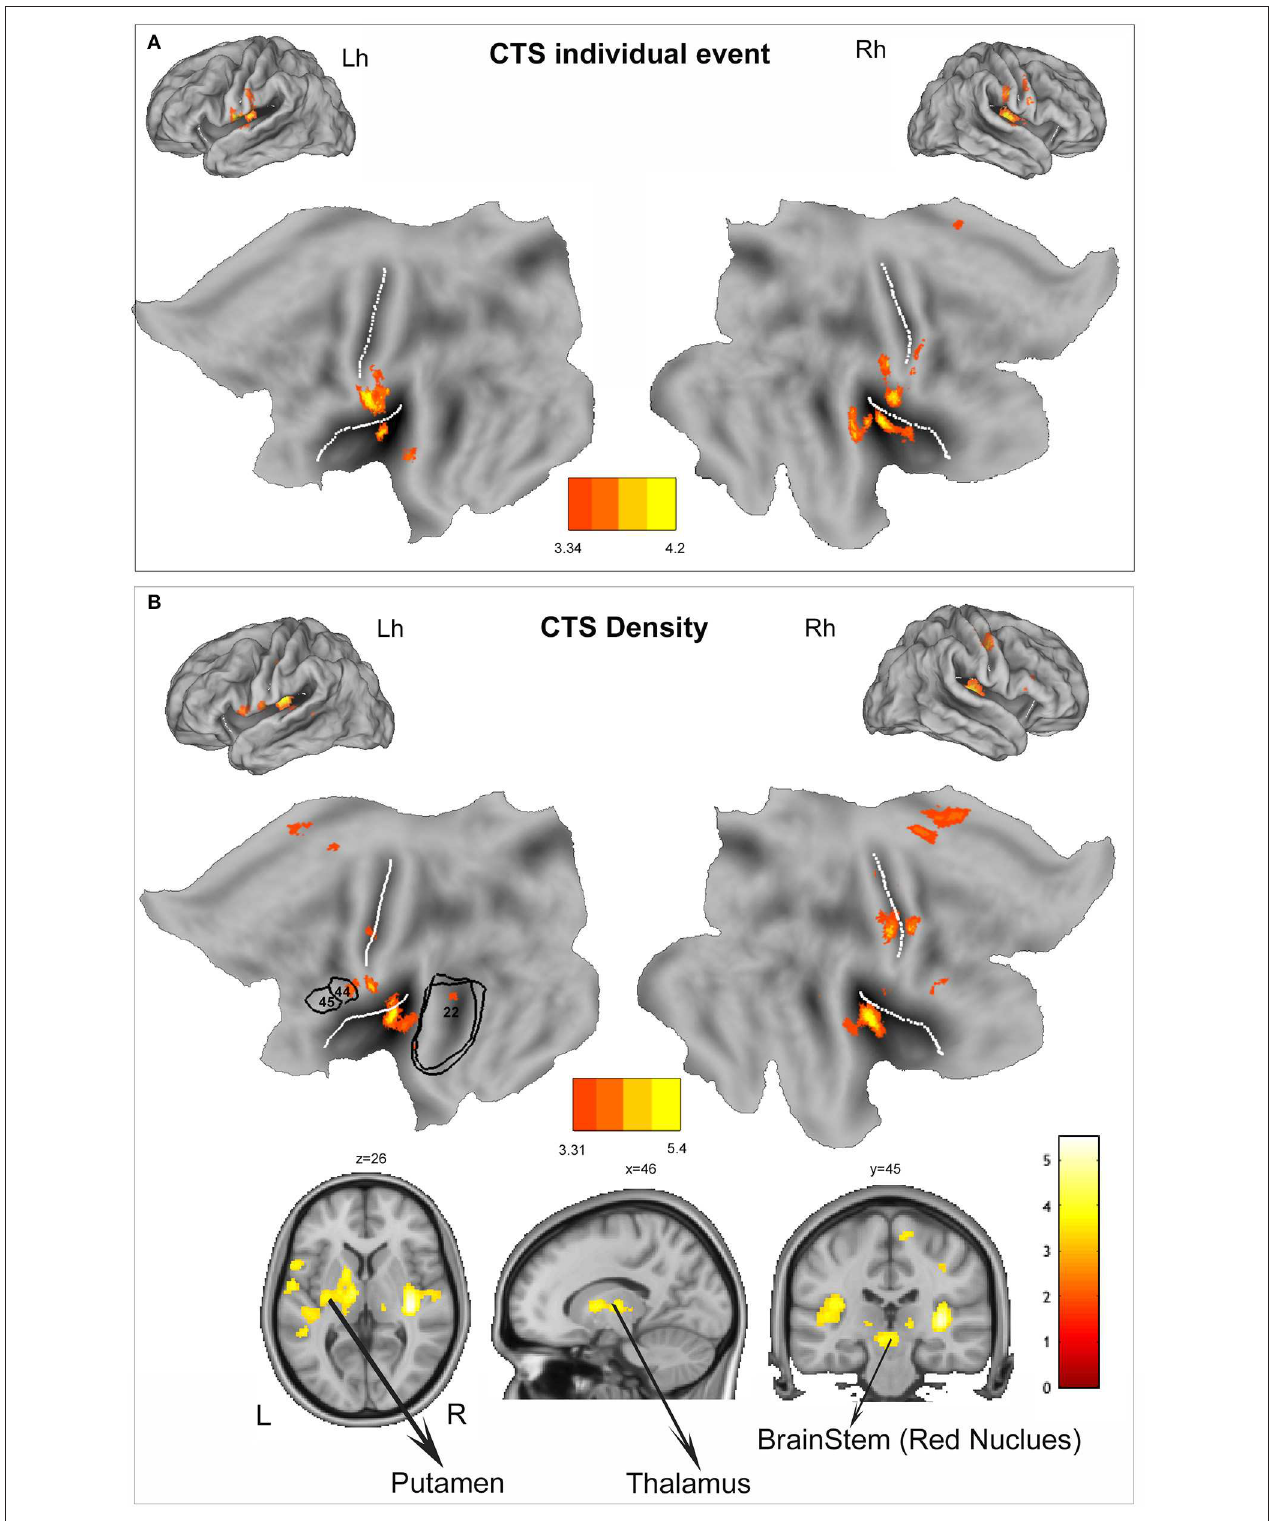
FIGURE 1 | (A) Group-level individual centrotemporal spike (CTS) model ( p < 0.001, 10 voxels extent). The functional maps are warped to the PALS-B12 atlas in caret (lateral view) for right (Rh) and left (Lh) hemisphere and to flat template. (B) Group-level density CTS model ( p < 0.001, 10 voxels extent). The functional mapsarewarpedtothePALS-B12atlasinCaret(lateralview)forright(Rh)andleft(Lh)hemisphereandtoflattemplate.Forlocalizationpurposes,functionalresultsonthe